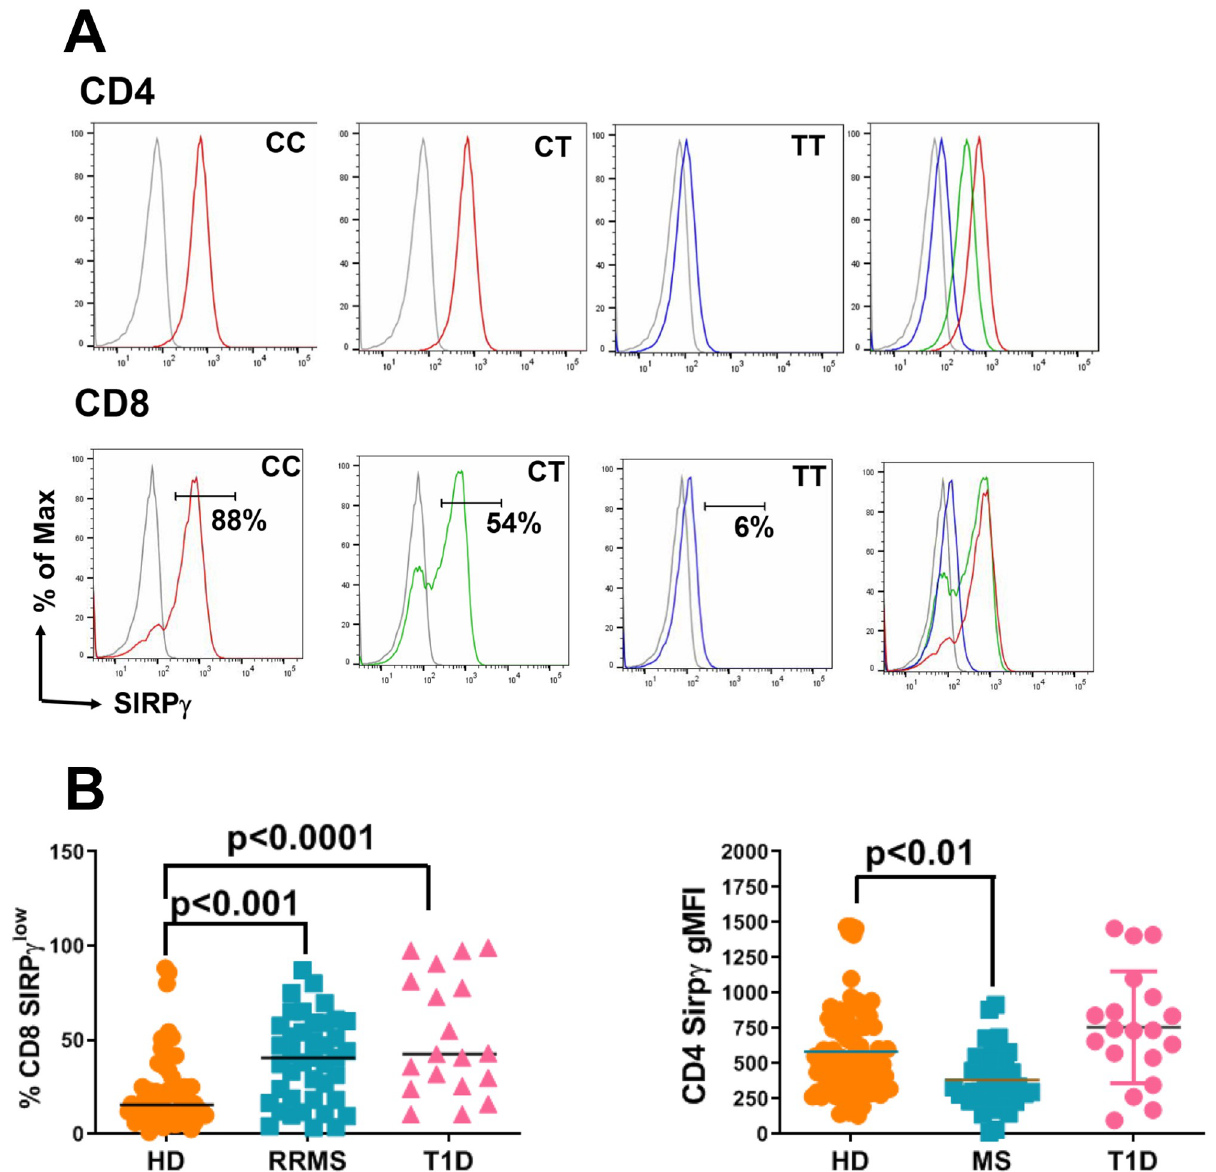
Fig 2. T-cells from RRMS and T1D patients have significantly reduced SIRP γ expression as compared to HD. Representative histograms for SIRP γ staining in RRMS patients is shown in A. Since SIRP γ shows a bimodal distribution on CD8 T-cells, SIRP γ low vs. SIRP γ high gates are shown for CD8 T- cells. Isotype control is shown in grey. PBMC samples from HD, RRMS and T1D patients were subjected to flow cytometry staining to detect SIRP γ on gated CD3, CD4 and CD8 T-cells as described previously [8]. SIRP γ gMFI data for CD4 T-cells and frequency of SIRP γ low CD8 T-cells are shown in B. One-way ANOVA with Tukey’s multiple comparison was performed and p < 0.05 was considered